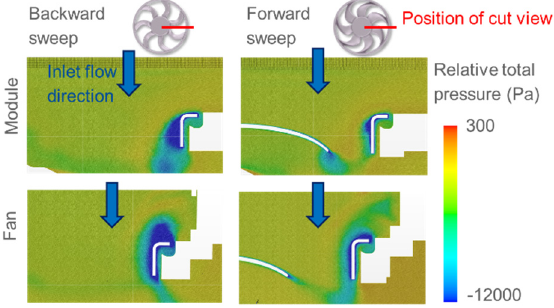
Figure 13. Cut view of the relative pressure distribution along the blade span.